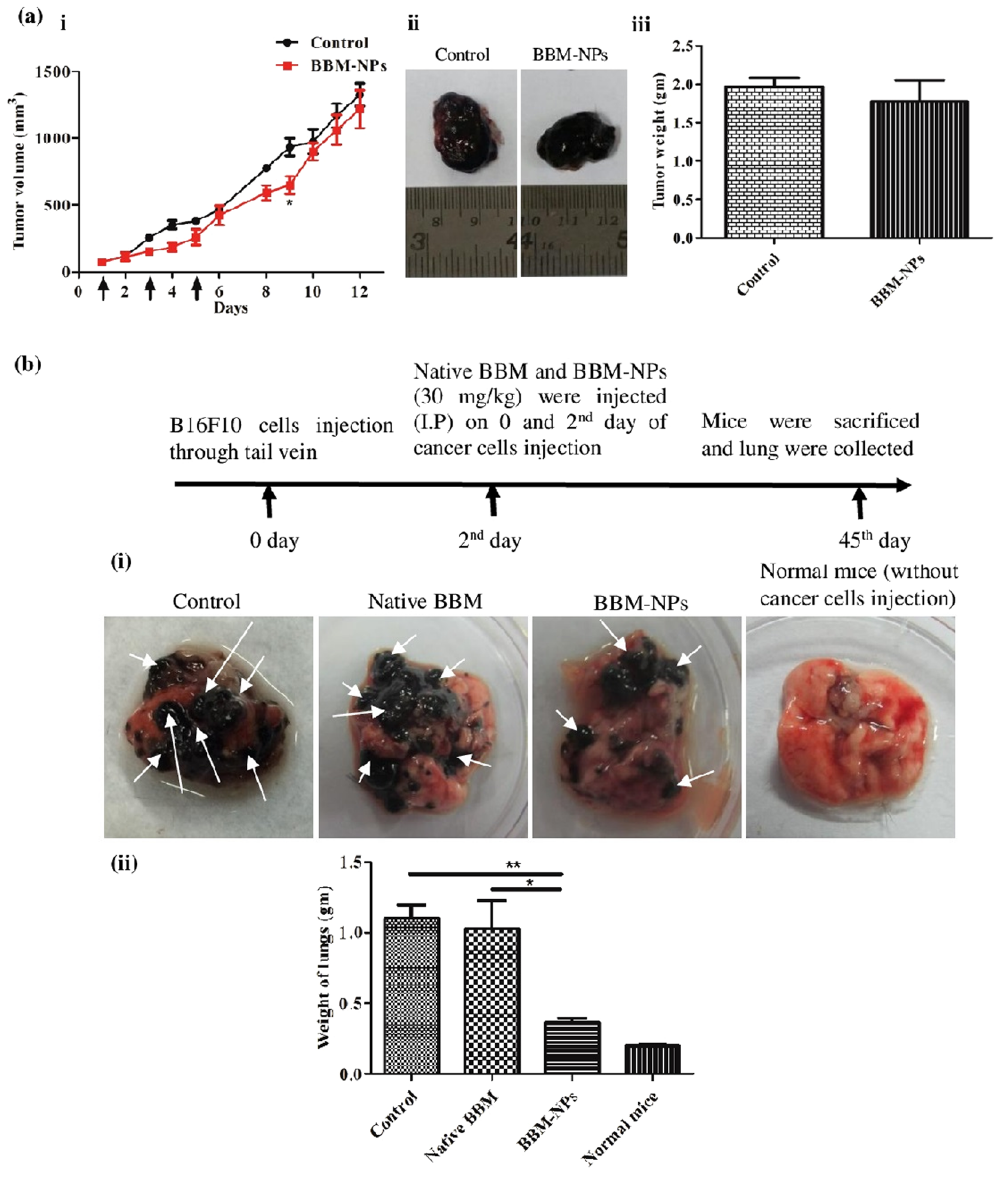
Figure 8. Anti-metastatic study of BBM-NPs in C57BL/6 mice melanoma model. ( a )To achieve a moderately cytotoxic dose of BBM-NPs to the tumor, initially we have developed a subcutaneous tumor model (detailed protocol in materials and methods) and injected BBM-NPs at a dose of 30 mg/kg body weight on 1 st , 3 rd and 5 th day intraperitoneally and finally sacrificed on 12 th day. (i) Tumor volume in mm 3 . (ii) The representative picture of the tumor. (iii) Tumor weight measured in grams. Data represented above are as mean ± SEM, n = 3. ( b ) To evaluate the efficacy of BBM to hematogenous lung metastasis, we have injected B16F10 cells (2 × 10 5 ) to the tail vein of C57BL/6 mice (n = 3). Next, we have injected Native BBM and BBM-NPs (30 mg/kg body weight) on 0 and 2 nd day of cells injection. After 45 days, the mice were sacrificed and lungs were collected and weighed. (i) The representative picture of the lungs. (ii) The weight of lungs in grams. The datas are represented as mean ± SEM, * p < 0.05, ** p < 0.005 for BBM-NPs treated mice vs. Native BBM and vs. control. Arrow indicates the tumor